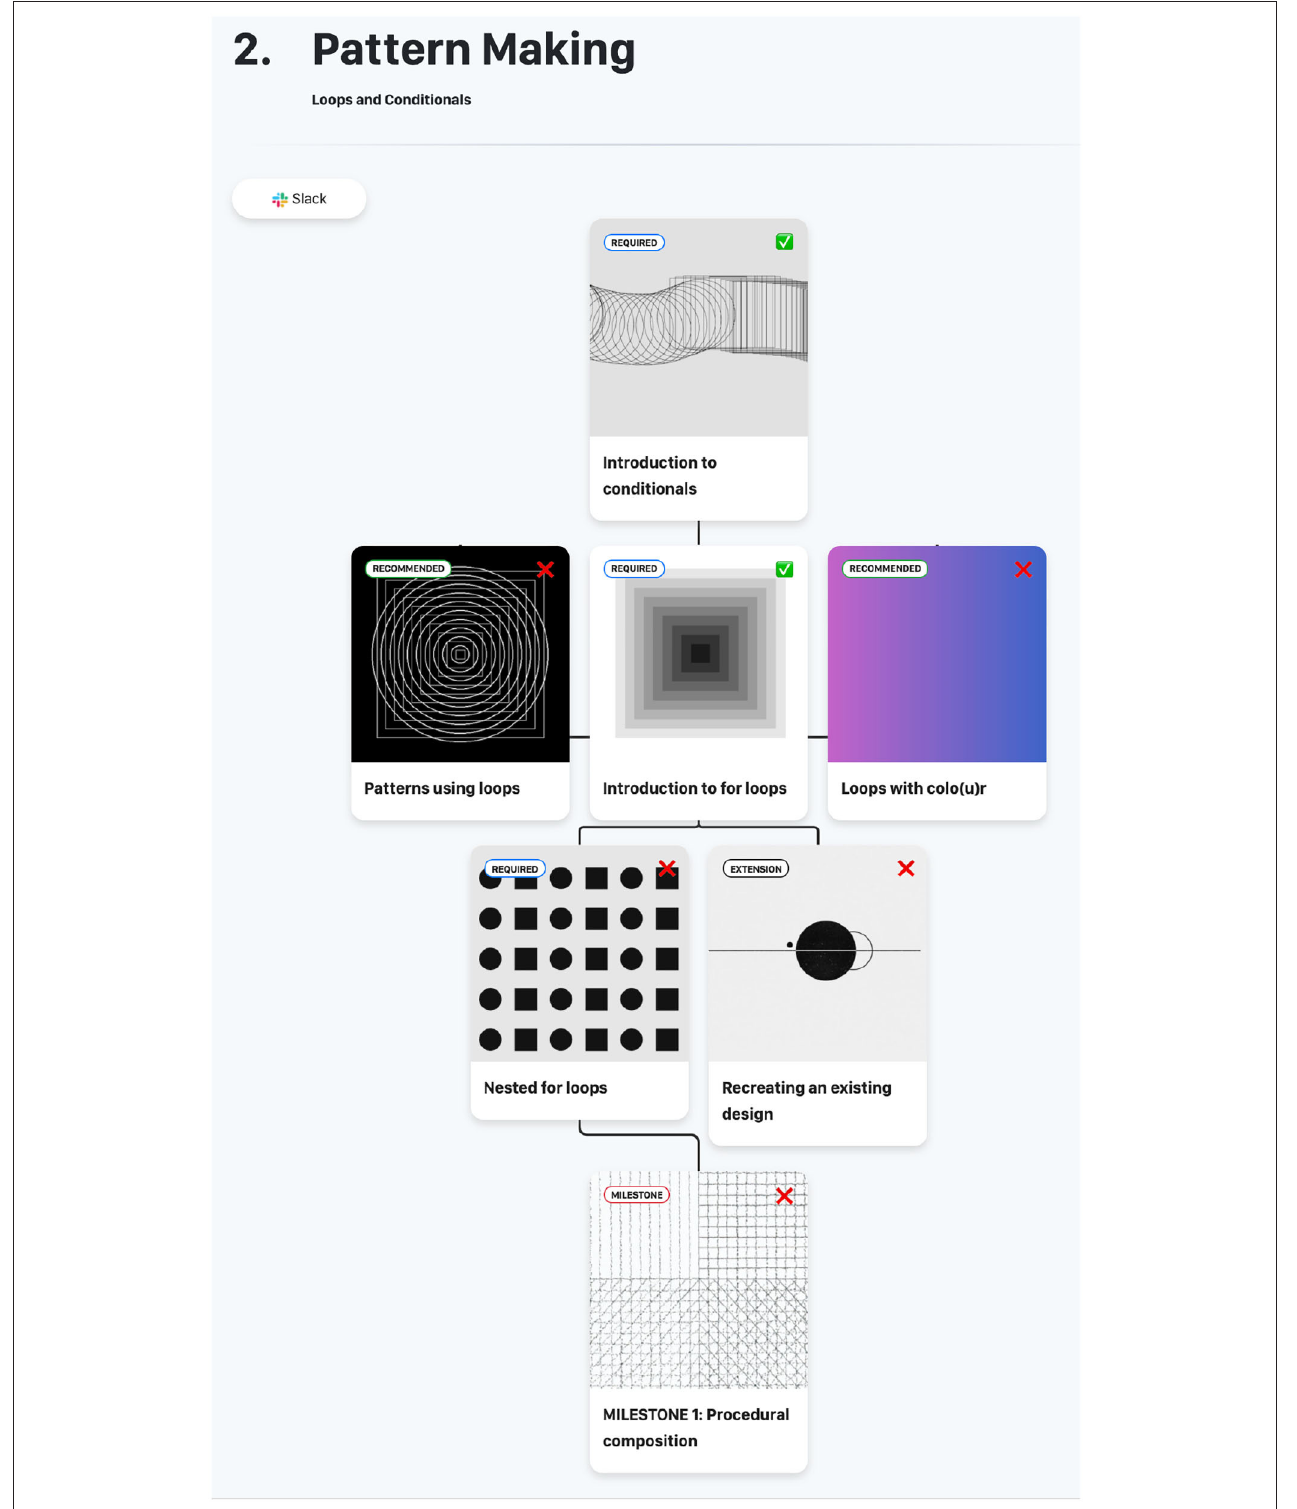
FIGURE 4 | The final UI used in the CCCs system, after the pivot to fully remote learning. By this point the notion of “challenges” had been expanded to cover all learning activities, not just open-ended extension material.